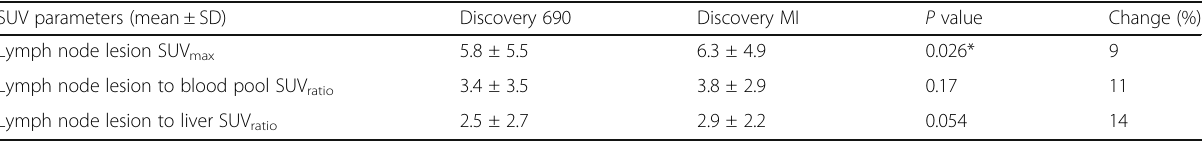
Table 3 SUV parameters in lymph nodes < 10 mm SUV parameters (mean±